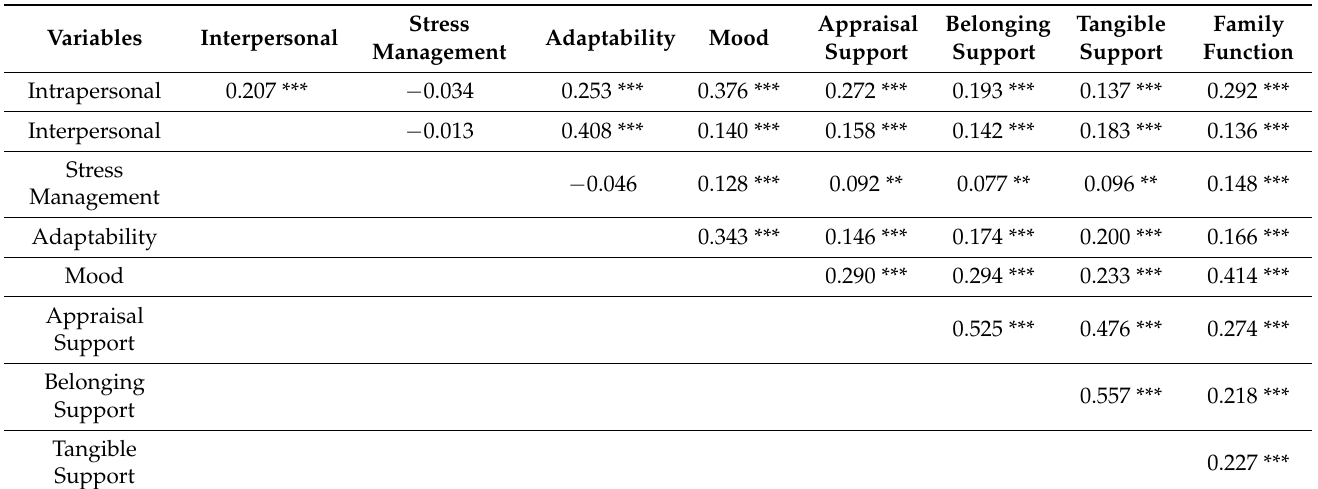
Table 3. Emotional intelligence factors, interpersonal support dimensions and family function. Pearson’s